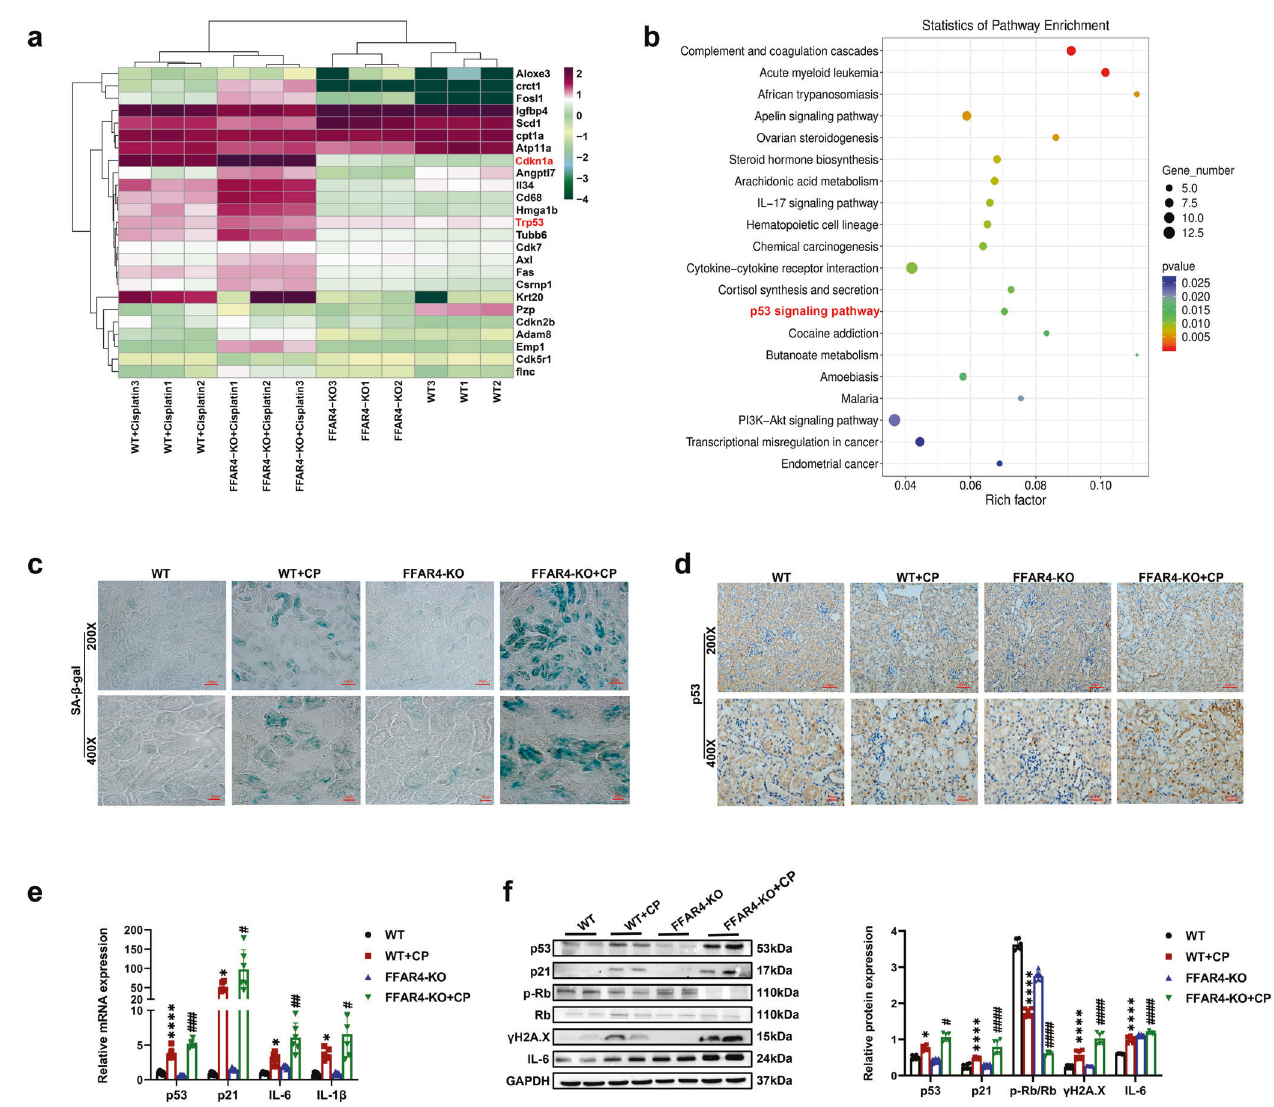
Fig. 4 FFAR4 de fi ciency aggravated cellular senescence in cisplatin-induced AKI mice. a Representative heatmap of differentially expressed genes in the kidneys of cisplatin-induced AKI mice ( n = 3). b Comparable analysis between WT + cisplatin and FFAR4-KO + cisplatin group using KEGG database. c SA- β -gal staining of kidney sections (200×, scale bar = 50 μ m; 400×, scale bar = 20 μ m). d Immunochemistry staining of p53 in kidney tissues (200×, scale bar = 50 μ m; 400×, scale bar = 20 μ m). e Relative mRNA expression of p53, p21, IL-6, and IL-1 β in kidney tissues ( n = 6). f Protein expression of p53, p21, p-Rb/Rb, ɣ H2A.X, and IL-6 in kidney tissues was detected by western blotting and quanti fi ed by densitometry ( n = 6). Data are presented as mean ± SD. CP, cisplatin. **** P < 0.0001, * P < 0.05. WT + CP vs. WT; #### P < 0.0001, ### P < 0.001, ## P < 0.01, # P < 0.5, FFAR4-KO + CP vs. WT +